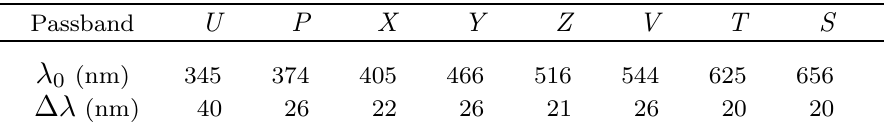
Table 1. Mean wavelengths and half-widths of passbands of the Vilnius photometric system (with T passband).